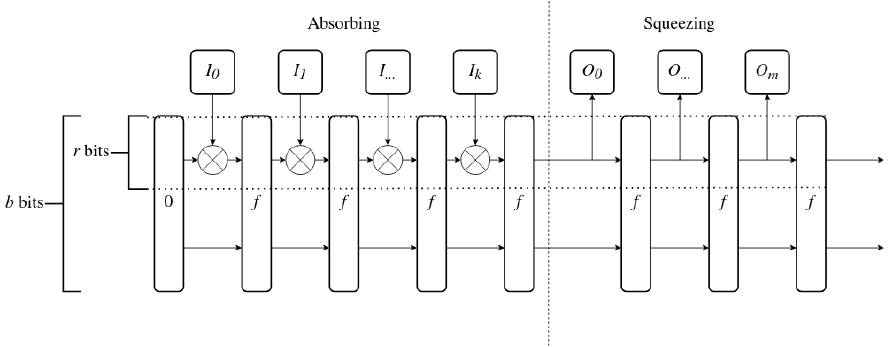
Figure 4. Sponge function.